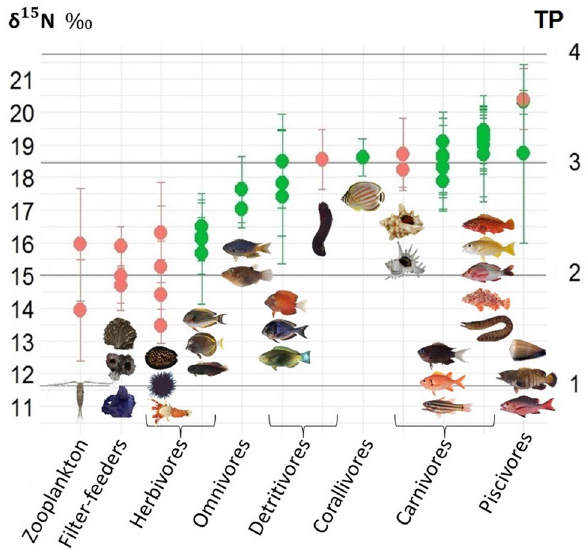
Figure 5. Relationships between mean bulk δ 15 N values and trophic positions (TPs) calculated with Sr-AA δ 15 N phe-gly values and with macroalgae as the main source of organic matter. Each dot corresponds to the mean TP for a species. Black circles for sources of organic matter, red circles for invertebrates, and green circles for